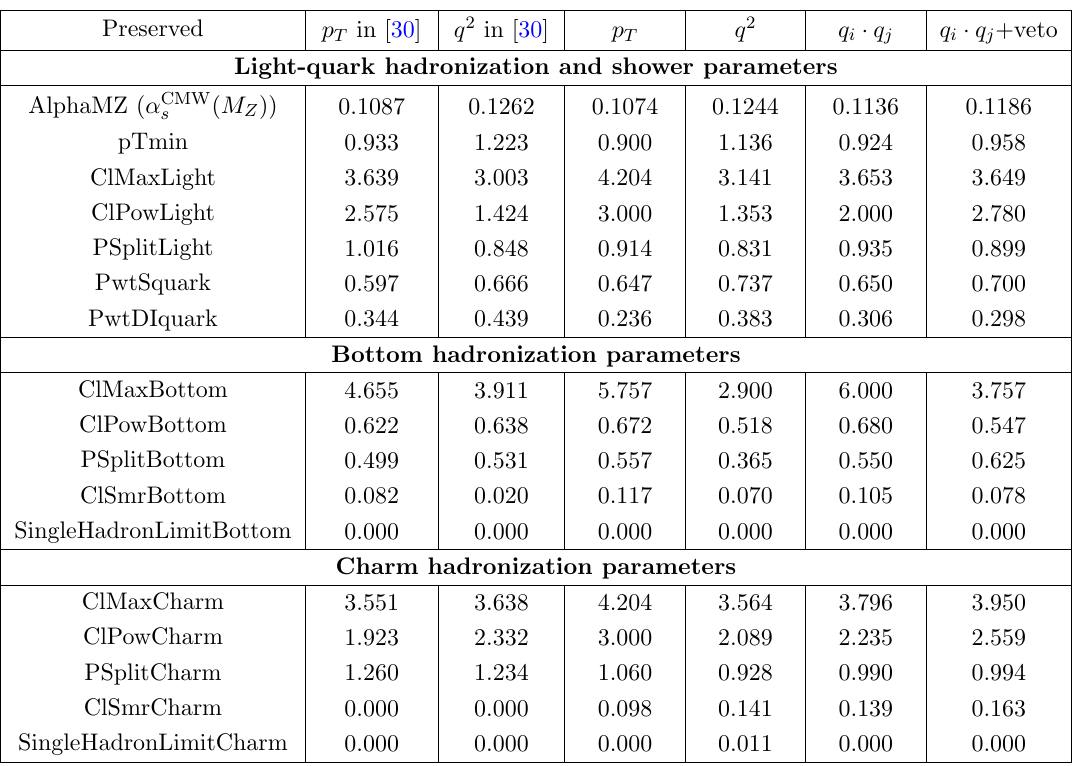
Table 1 . The Monte Carlo parameters obtained for di(cid:11)erent choices of the preserved quantity in the angular-ordered shower.